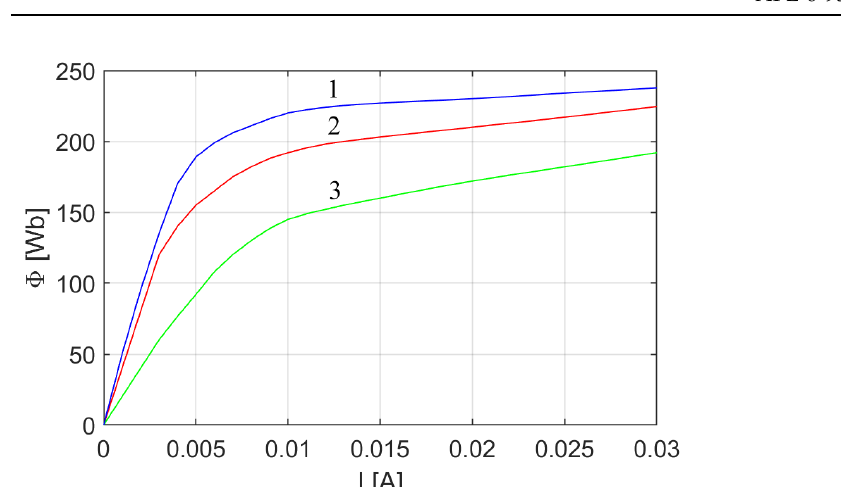
Figure 3. Magnetization characteristics of voltage transformers, the cores of which are made of sheets (1) with the lowest loss, (2) with intermediate loss, and (3) with the highest loss.